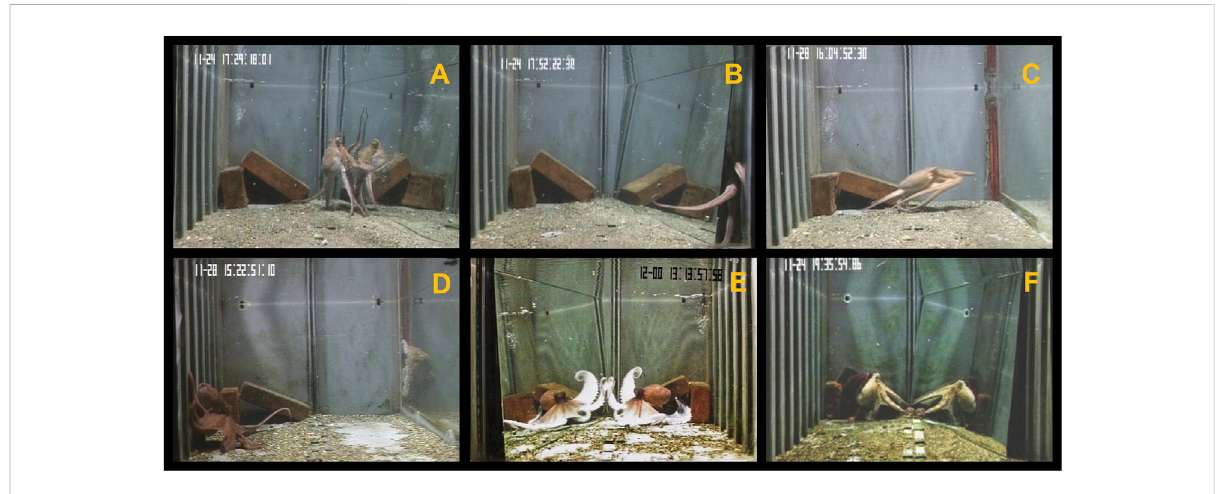
FIGURE 1 Octopus ’ response toward the mirror (A,B,E,F) and the conspeci fi c (C,D) . Behaviors recognized: (A) Physical contact ; (B) Behind stimulus ; (C) Attack ; (D) Active avoidance ; (E) Bishop ; (F) Unilateral